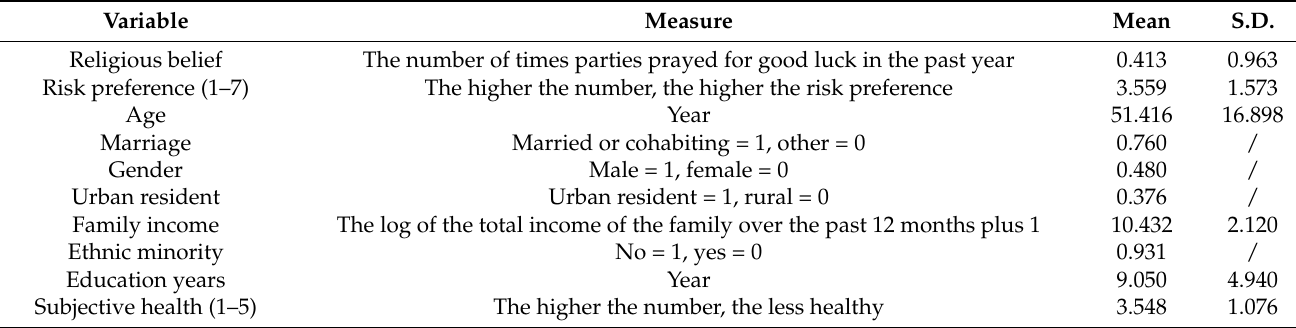
Table 3. Descriptive information for variables in the CGSS 2018 (N =